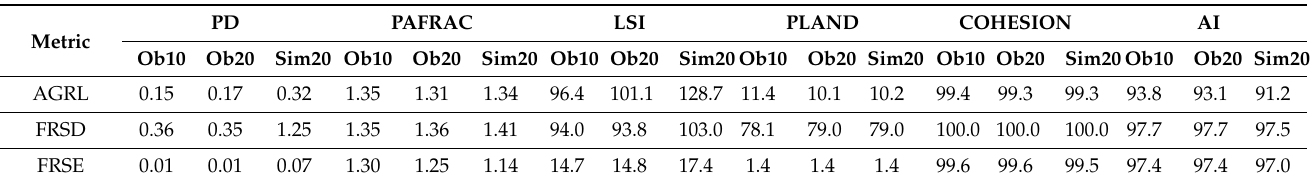
Table A2. Observed and simulated landscape pattern metrics of